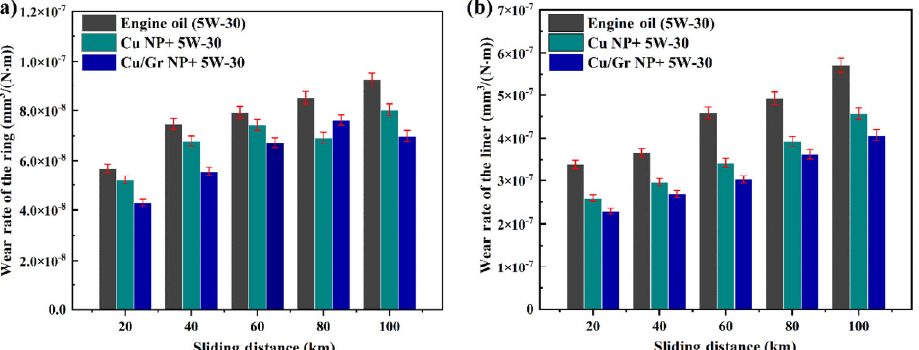
Fig. 7 WR of the rubbing surfaces for both the nano-additives and reference oil with respect to different sliding distances: (a) piston ring and (b) cylinder liner. The error bars indicate the standard